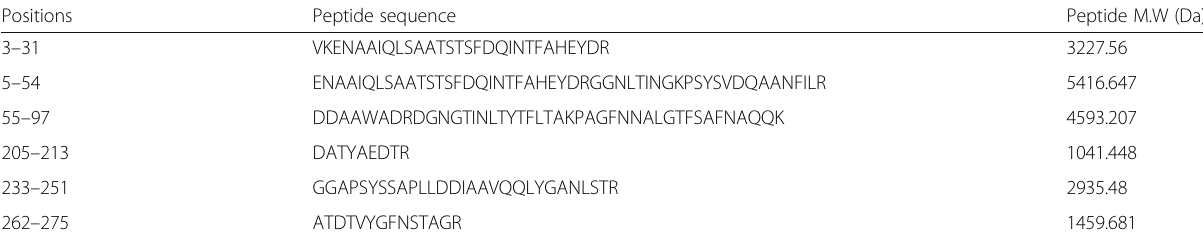
Table 5 Peptide matching of S.AMP13 with alkaline metalloprotease from Pseudomonas syringae pv.maculicola (Accession no. KPB92383.1)